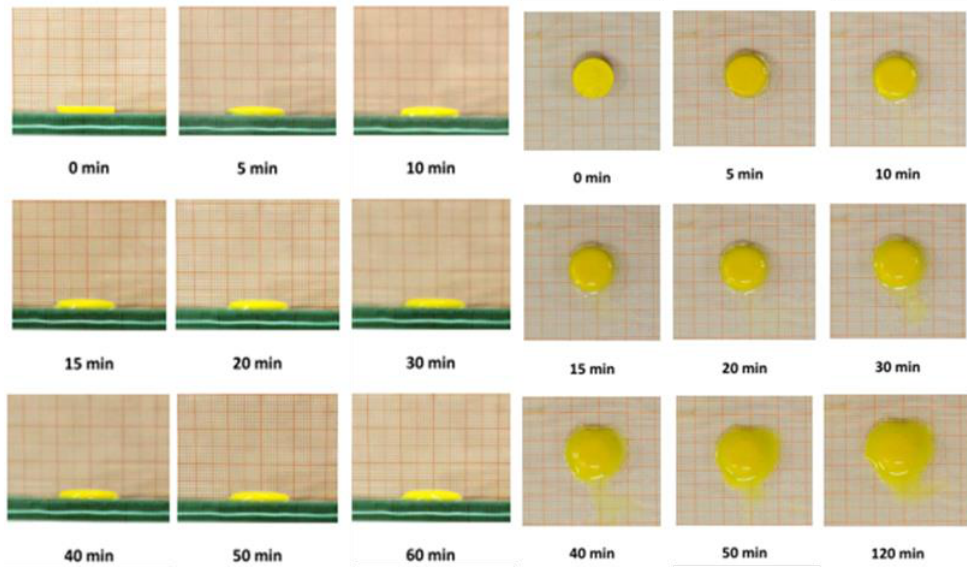
Figure 5. Timeline from 0 to 120 min of the plan and frontal swelling of the tablet.